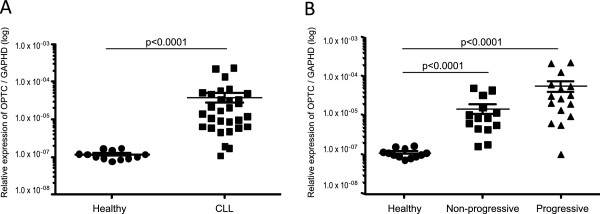
Quantitative OPTC gene expression (q-PCR) in PBMC of CLL patients (non-progressive/progressive) and healthy controls. A The relative expression of OPTC was significantly higher in CLL patients (n = 30) compared to healthy control donors (n = 12) (p < 0,0001). B The relative expression of OPTC was higher in progressive (n = 16) and non-progressive (n = 14) patients compared to healthy donors (p < 0,0001). There was no significant difference in OPTC expression between non-progressive and progressive CLL. Relative expression of OPTC was calculated using the ΔCt method and GAPDH as reference gene.